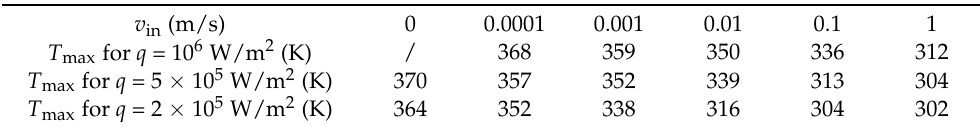
Figure 8. The temperatures with the velocity vector for various inlet velocity when q = 5 × 10 5 W/m 2 . Table 4. The highest temperatures on the wall with heat source for various inlet velocities and heat fluxes.